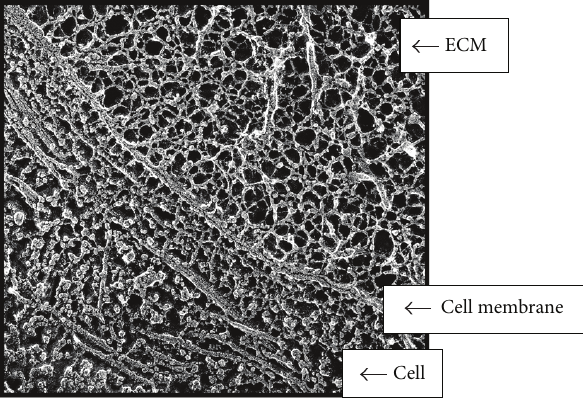
Figure 1: Interconnected structural components of cells and ECM. Quick freeze, deep etch electron micrograph of a fetal ear cartilage chondrocyte cell to illustrate the integration of structures inside and outside the cell. The ECM (containing a meshwork of proteoglycans, collagen, fibronectin, and laminin), the cell membrane (integrins receptors), and the cell (containing microtubules) are visualized. In the ECM the thinnest fibrils in the meshwork are 4 ± 𝐼 nm and are presumed to be proteoglycans. The larger thicker fibrils are collagen. Micrograph courtesy of Robert Mecham and John Heuser, Washington University, St. Louis, MO, USA. This figure illustrates that mechanical forces can be transmitted across the cell surface and into the cell by means of interconnected structural components (as discussed in